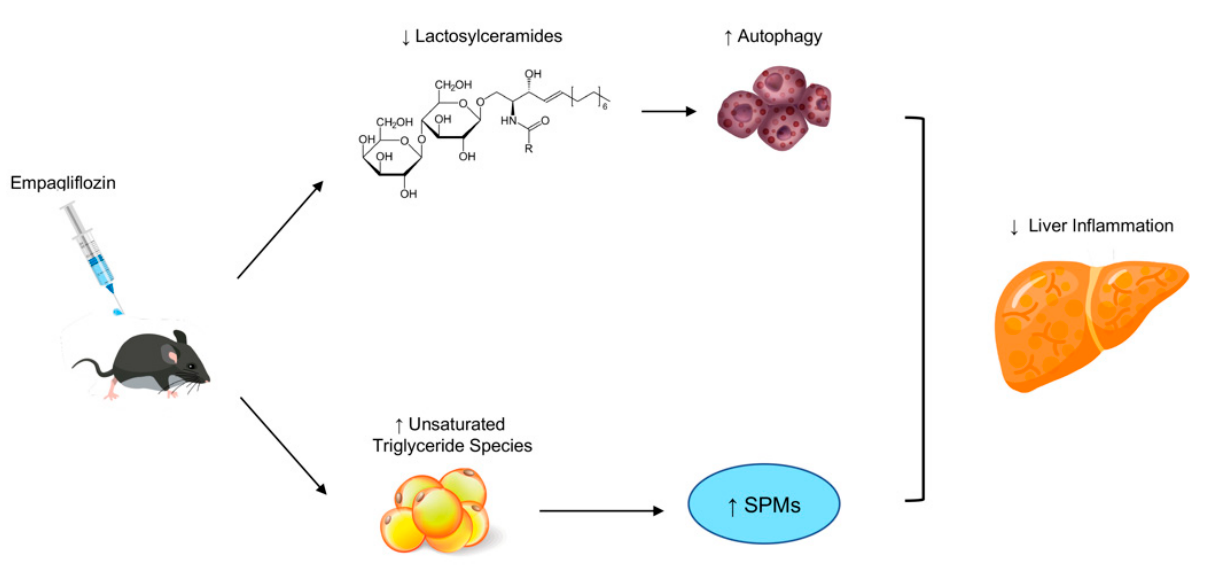
Figure 6. Potential mechanism of the function for empagliflozin in NASH. Lactosylceramides act as pro-inflammatory mediators and disruptors of autophagy procedures [22,23]. Treatment with empagliflozin in our study decreased the hepatic concentrations of lactosylceramides, which may explain the enhancement of autophagy that has been observed in previous diabetic mouse models of NAFLD treated with empagliflozin [12,13]. Additionally, treatment with empagliflozin increased the concentrations of triglyceride species consisting of unsaturated fatty acids. The metabolism of unsaturated fatty acids has been associated with the formation of specialized pro-resolving mediators (SPMs) that demonstrate anti-inflammatory properties